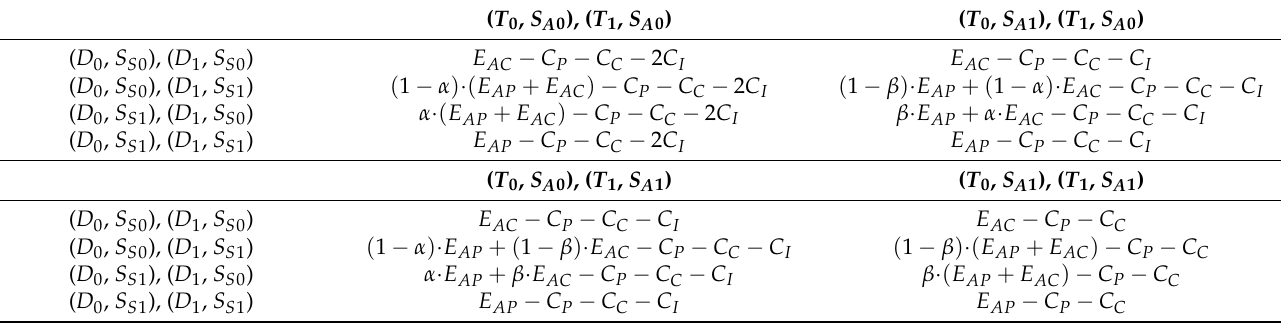
Table 2. Income Function of the Attacker.